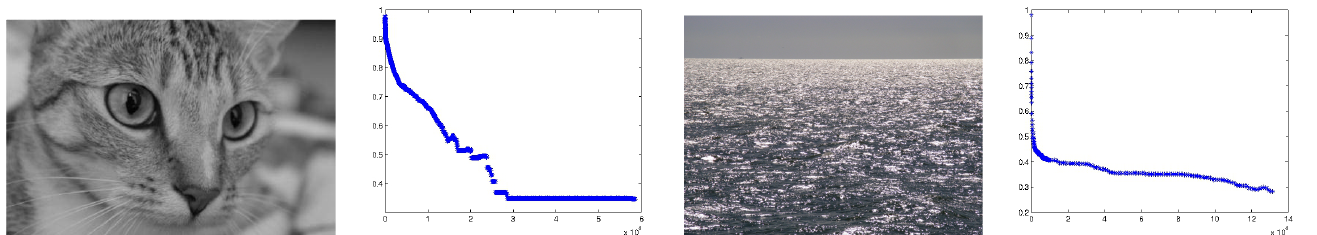
Fig. 5. MSSIM values comparing P n ( f ) with f values plotted against scale for the Cat image and an Ocean image